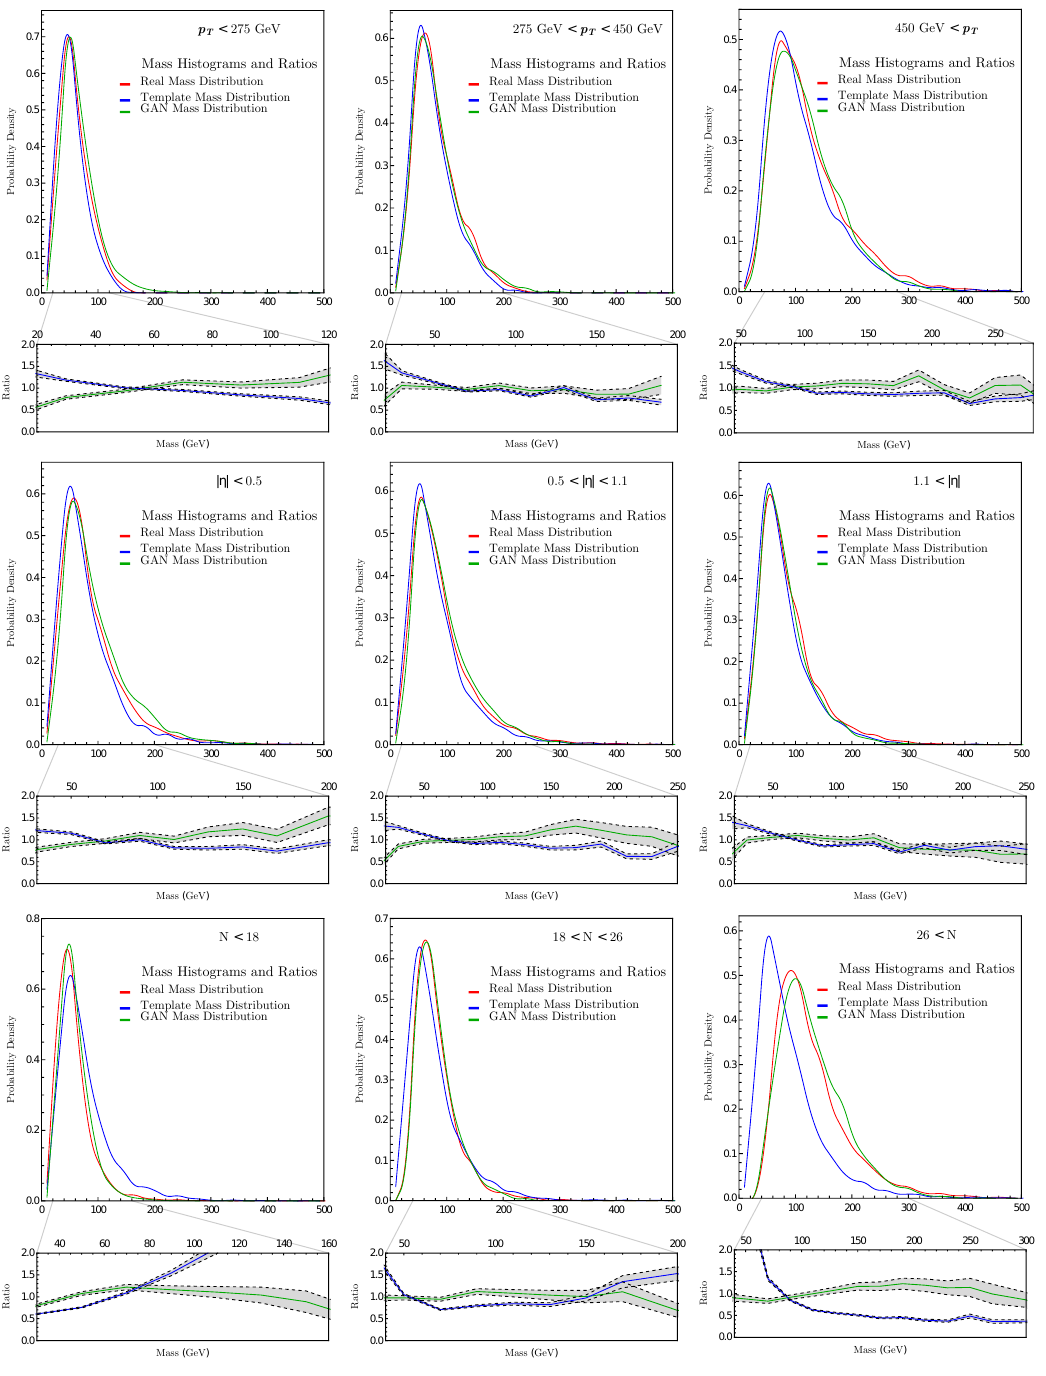
Figure 5 . The physics-based (‘real’) mass distributions compared with distributions from the tem- plate method and the vanilla GAN in bins of jet p T (top row), (cid:17) (middle row), and N (bottom row). The uncertainty in the ratio was calculated as the 1-sigma error assuming poisson distribu- tions of events in each bin. The error shown in the plots is the calculated statistical error. The corresponding plot in the control region is qualitatively similar, but converges quicker.